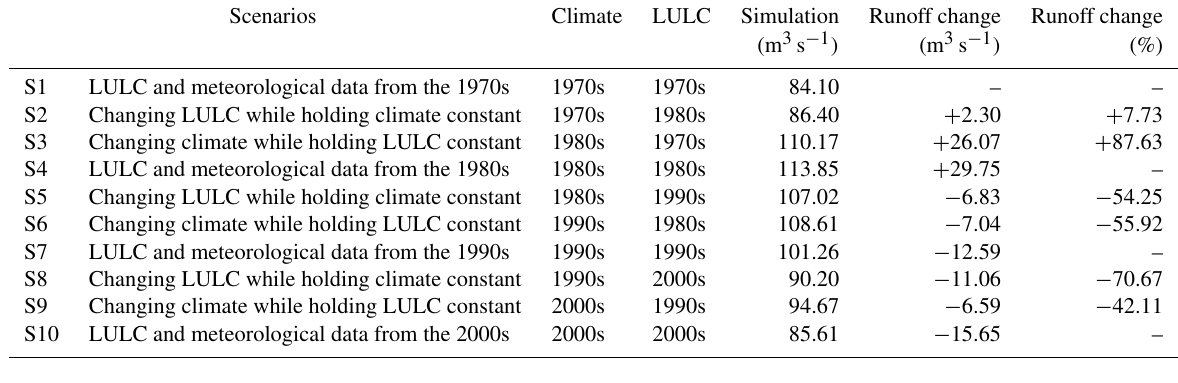
Table 3. Simulated annual runoff by SWAT under different scenarios considering both LULC and climate.